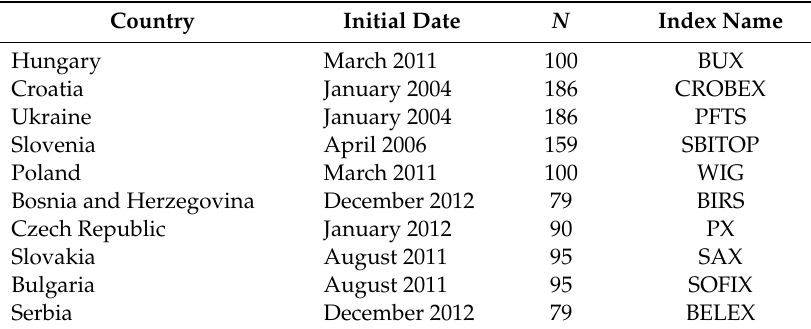
Table 1. Data time span by country. Country Initial Date N Index